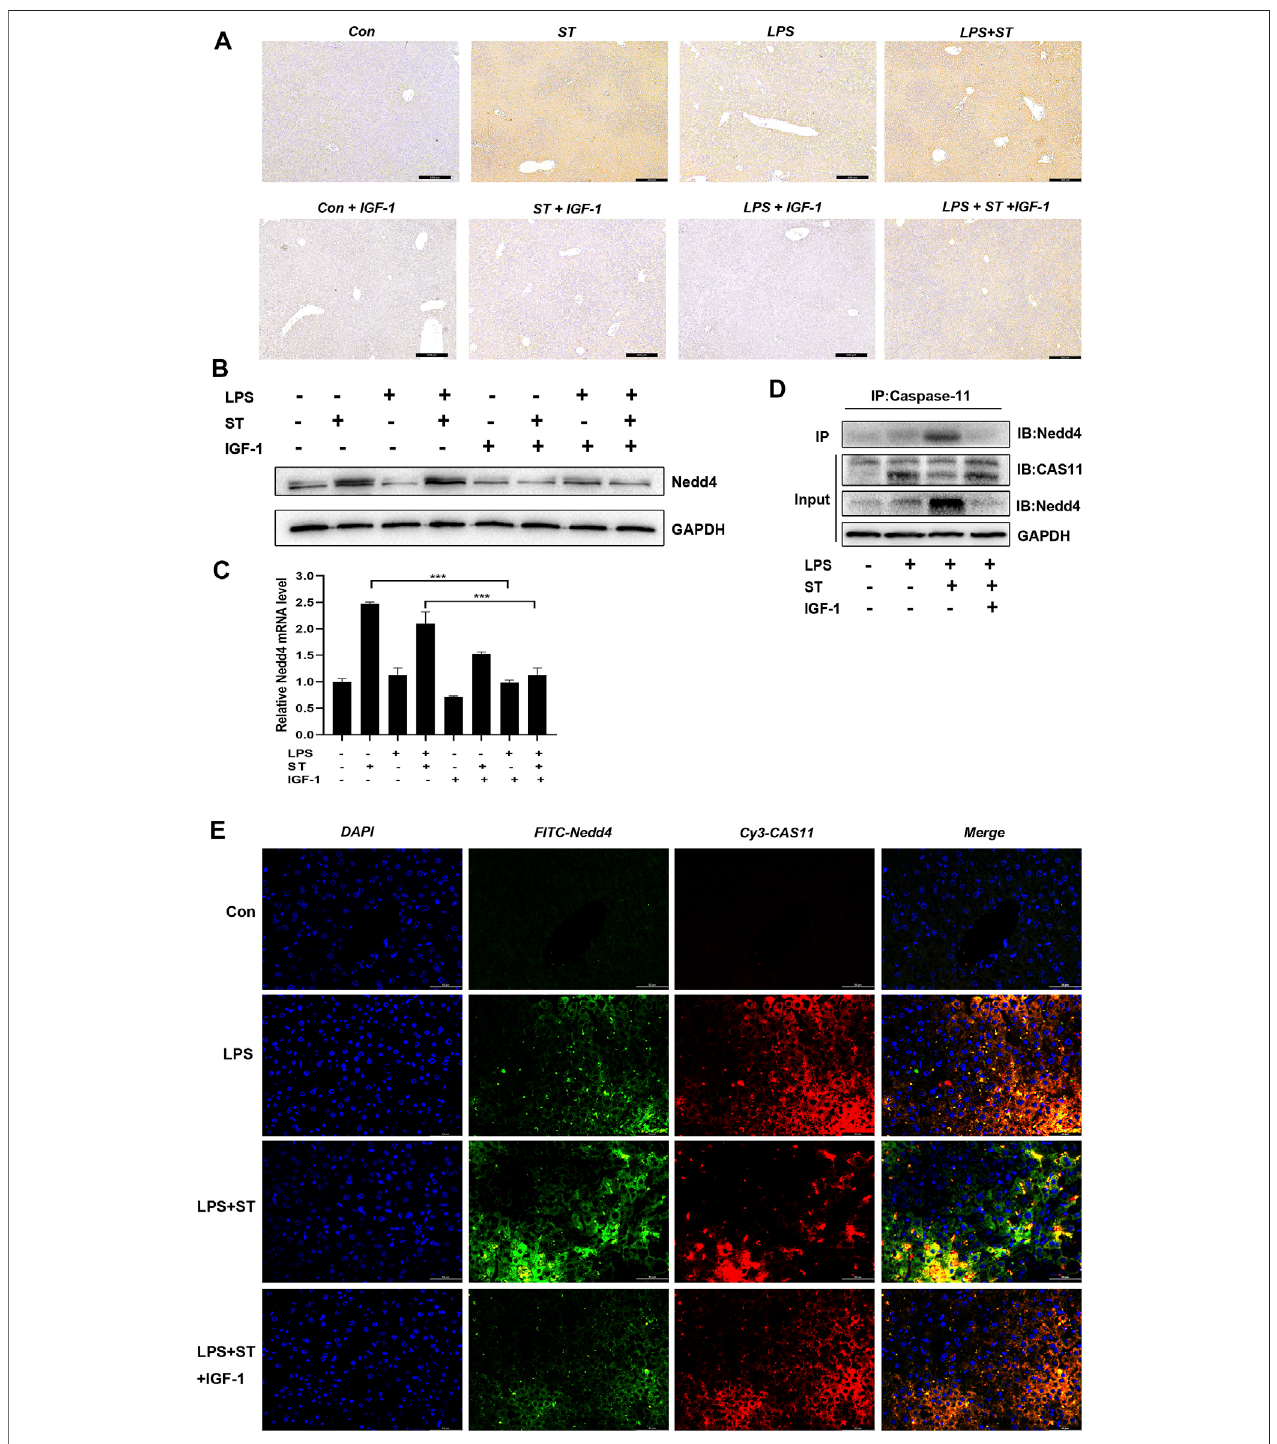
FIGURE 6 | Nedd4 interacts withcaspase-11 and targetsitfor degradation. (A) Representative immunohistochemical imagesofNedd4 inliver sections (scale bars (cid:1) 100 μ m). (B) WesternblottingshowingtheproteinlevelsofNedd4and (C) qRT-PCRresults. (D) Lysatesoflivertissueimmunoprecipitatedwithananti-caspase-11antibody and western blotting with the indicated antibody. (E) Immuno fl uorescence assays. Nedd4 was detected using an anti-Nedd4 primary antibody and FITC goat anti-rabbit antibody;caspase-11wasdetectedusingananti-caspase-11primaryantibodyandCy3-labeledgoatanti-mouseantibody(scalebar (cid:1) 50 μ m).Dataarepresentedas the mean ± SD; * p < 0.05, ** p < 0.01, *** p < 0.005.